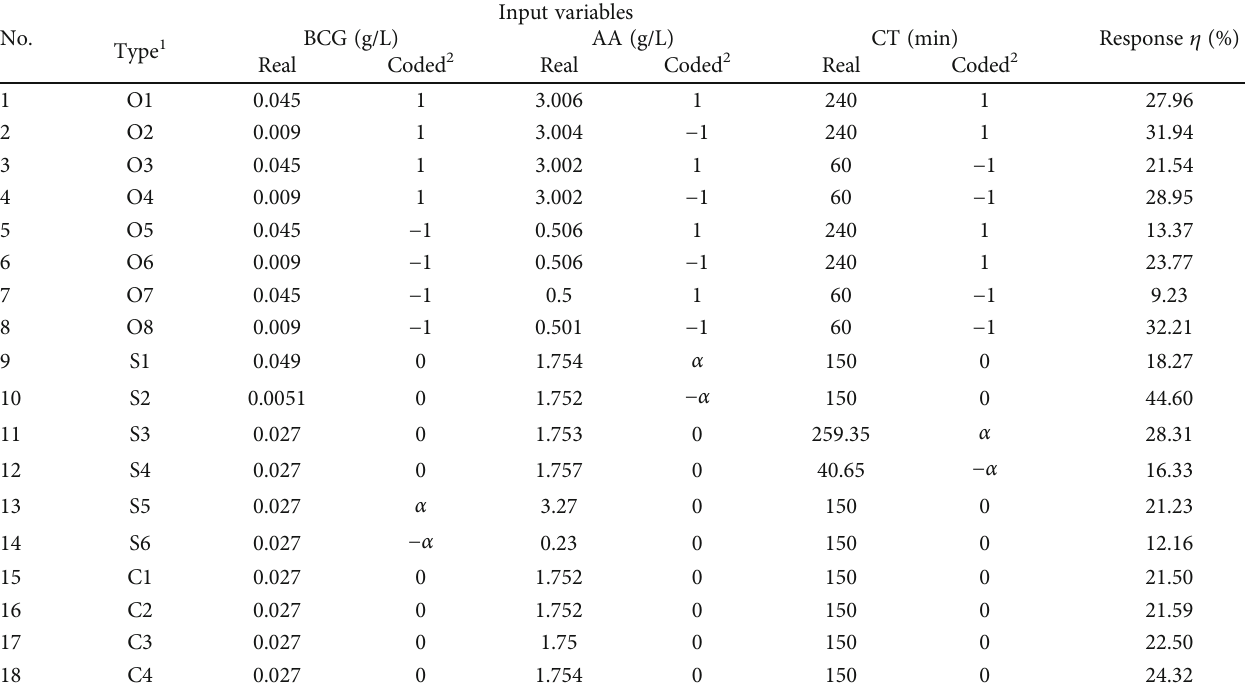
Table 3: Designated variables and their variation range for BCG decolorization with active carbon. No.